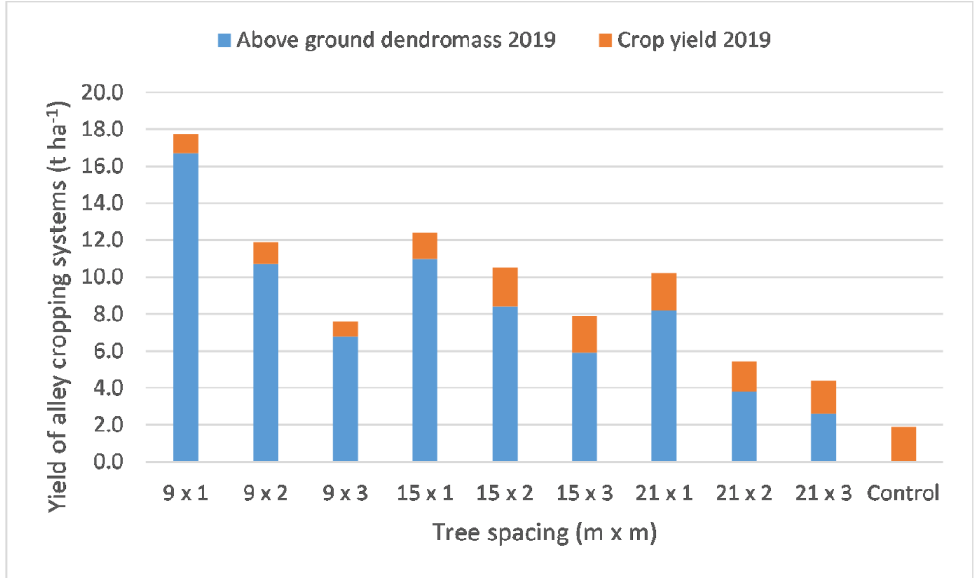
Figure A2. Yields of triticale–black locust alley cropping systems in 2019 according to the tree spacing, based on above-ground dendromass. The trees were 5 years old.